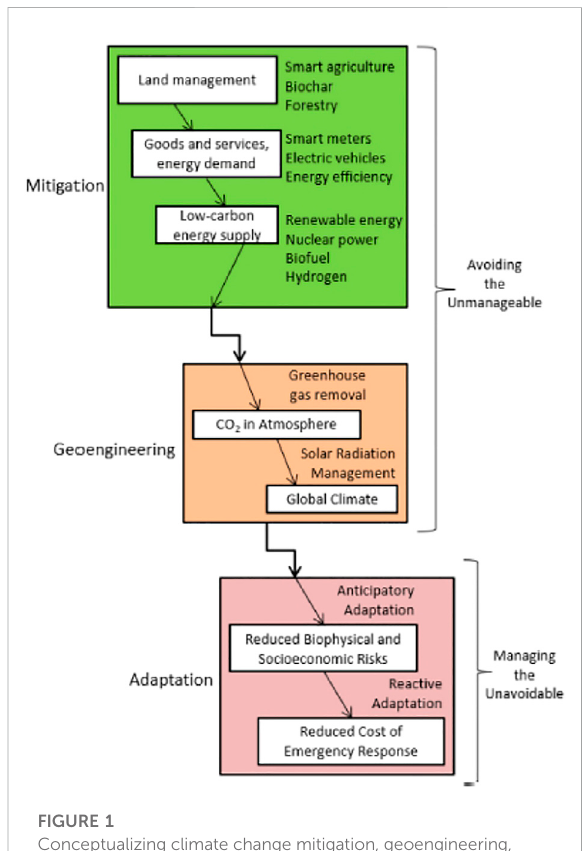
FIGURE 1 Conceptualizing climate change mitigation, geoengineering, and